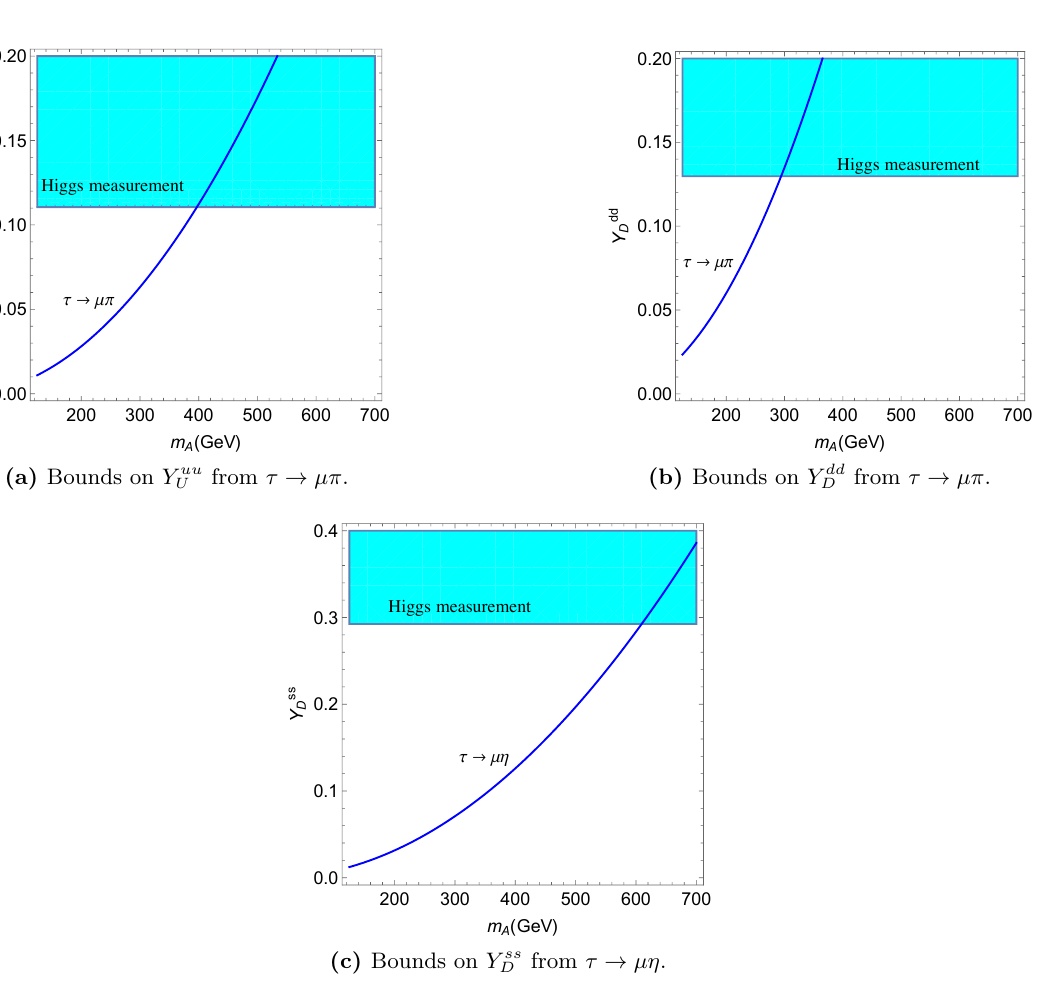
Figure 9. The solid blues line in these plots show the bounds for Y uu as a function of m A for Y (cid:28)(cid:22) = 0 : 01. Here P represents the pseudoscalars mesons: (cid:25) or (cid:17) . The ‘ region above the lines are excluded by the searches. The shaded regions are excluded from the kinematics of light Higgs productions for sin (cid:11) = 0 : 1. In calculating these bounds, we take only one of the Y ’s to be nonzero, while the others are